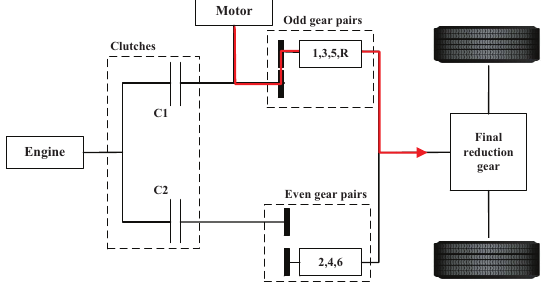
( a ) The power flow of the hybrid dual clutch transmission (DCT) in pure electric drive mode.